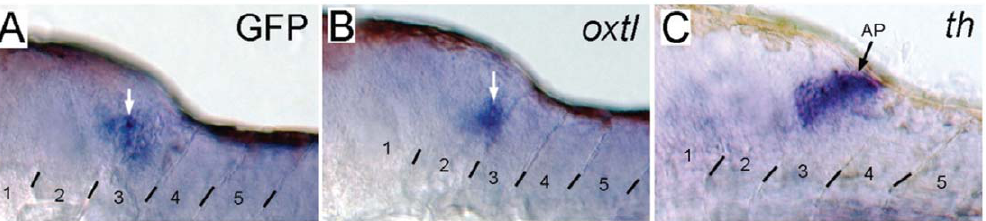
Figure 8. Expression of oxtl mRNA is induced in the hindbrain by exposure to ethanol. Whole mount in situ hybridization was used to detect: A , GFP ; B , oxtl ; and C , tyrosine hydroxylase ( th ) mRNAs in Tg(oxtl:GFP) larva treated with ethanol for 24 hrs at 4 dpf, and then fixed at 6 dpf. th labels dopaminergic and noradrenergic neurons located in the area postrema. Examples of positive staining are indicated by arrows.